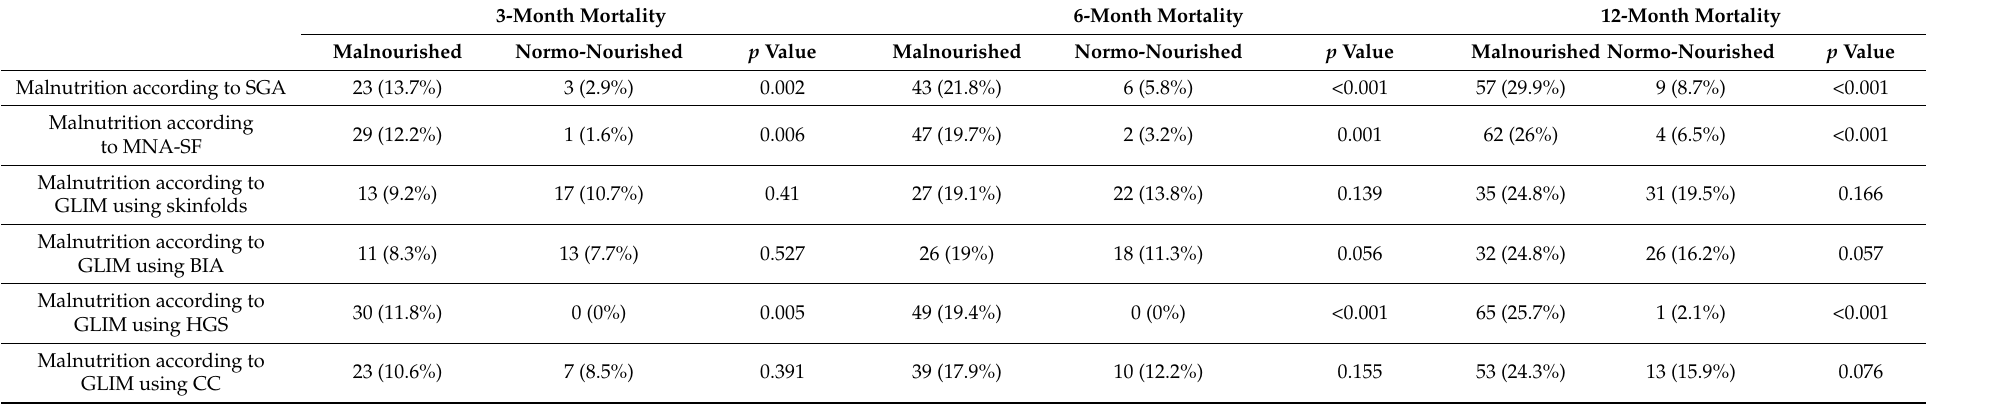
Table 3. Relationship between malnutrition and mortality.